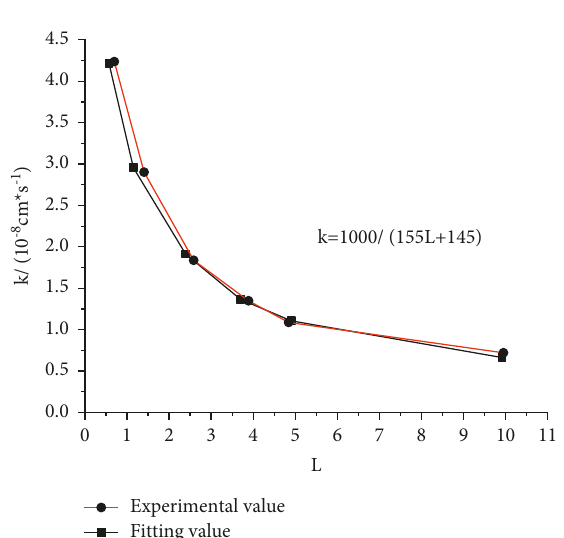
Figure 1: L Relationship curve between loading proportional coefficient and permeability coefficient.